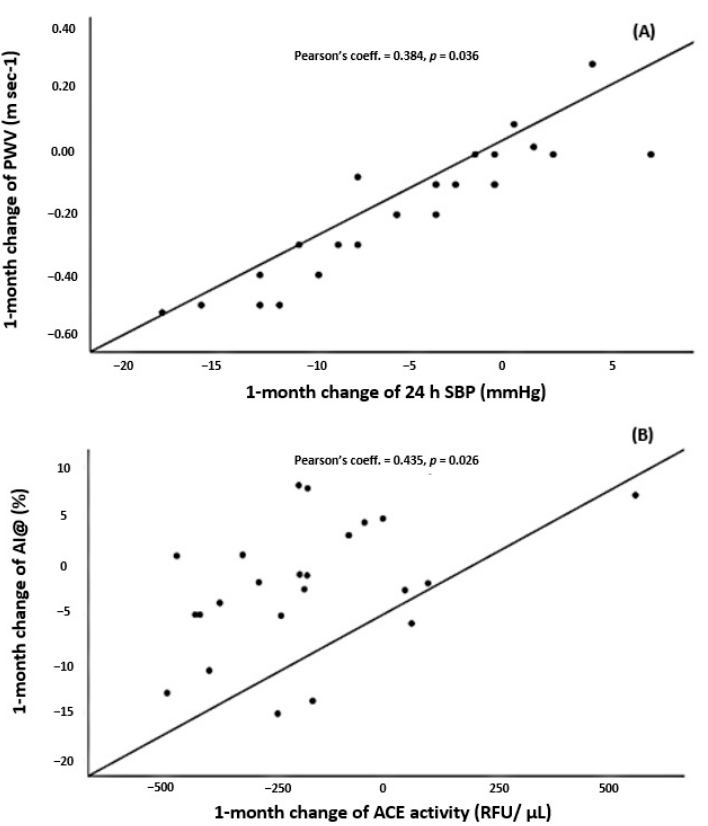
Figure 1. ( A ) Scatter plot for the correlation between change of PWV and change of 24 h SBP one-month after bariatric surgery. ( B ) Scatter plot for the correlation between change of AIx@75 and change of ACE one month after bariatric surgery. ACE = angiotensin converting enzyme; AIx@75 = augmentation index at 75 beats/minute; PWV = pulse-wave velocity; SBP = systolic blood pressure.